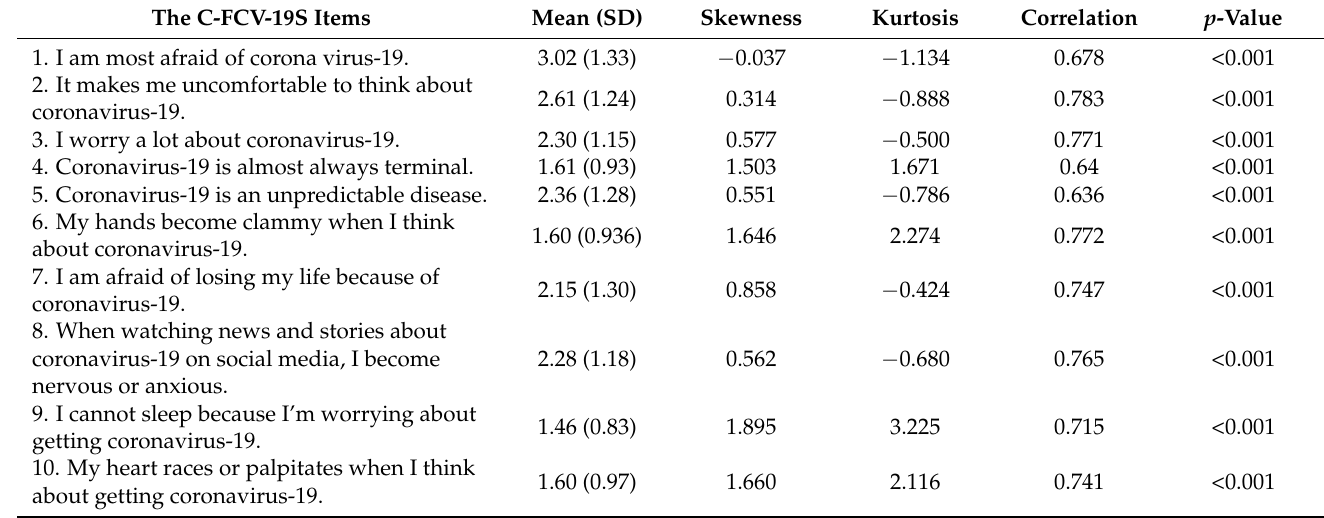
Table 2. Item Analysis of the Chinese version Fear of COVID-19 scale (The